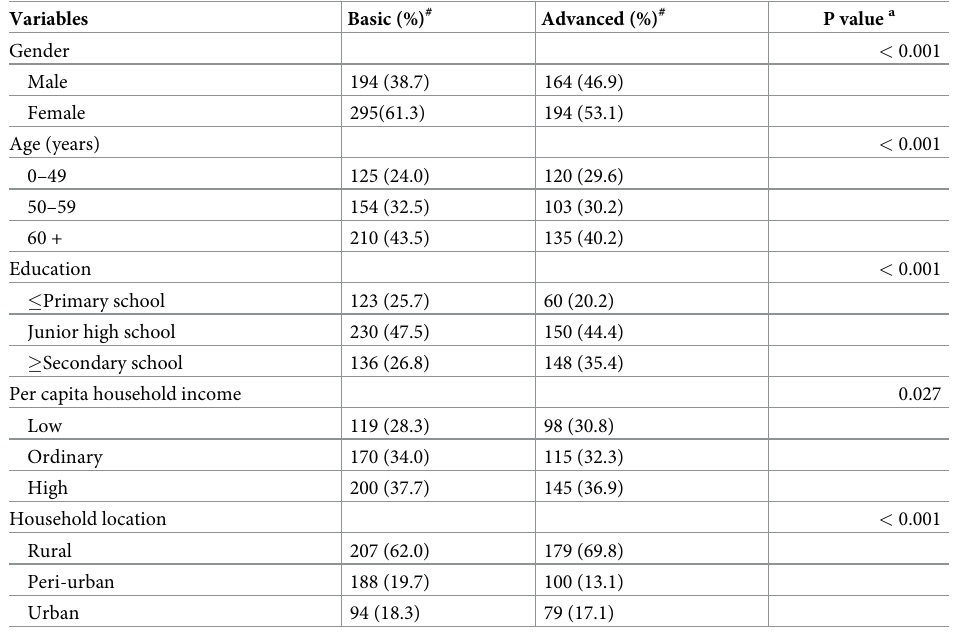
Table 2. The differences of residents’ characteristics by disaster response knowledge. Variables